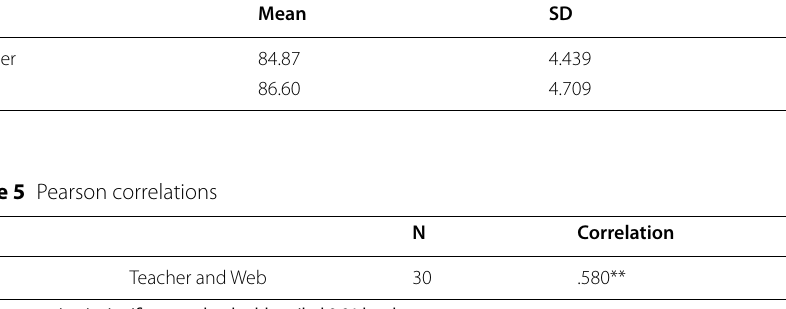
**The connection is significant at the double-tailed 0.01 level